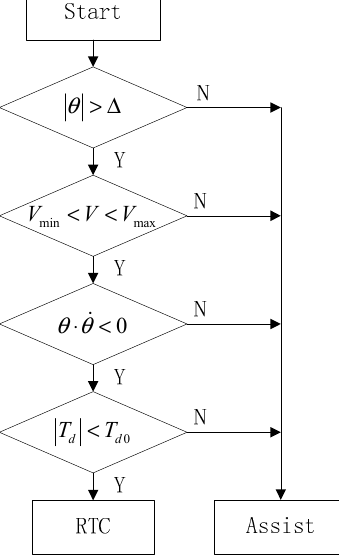
Figure 3. Flow chart of judging state switch.